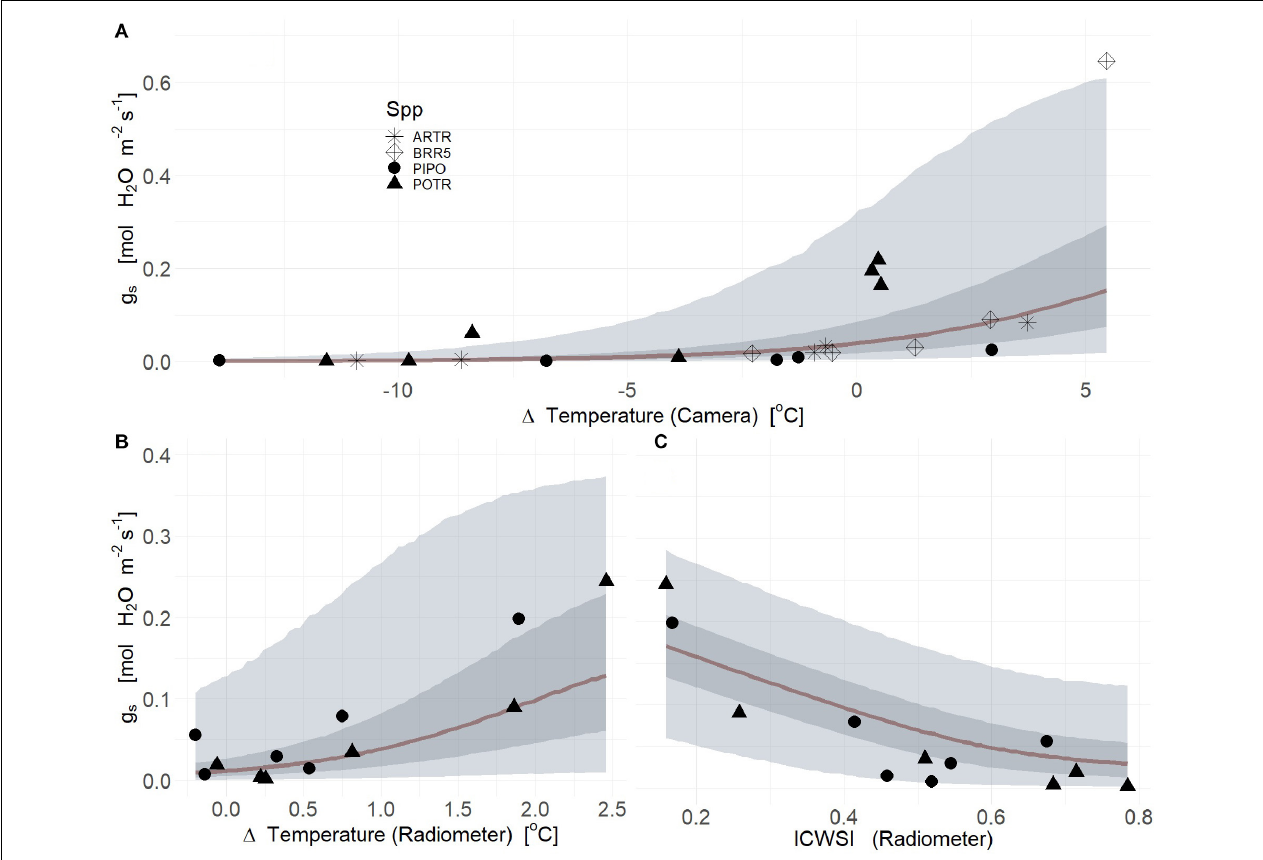
FIGURE 6 | Thermal images (A) Infrared radiometers (B,C) measured deltaT (air minus leaf temperature) (A,B) and I CWSI (C) serve as powerful predictors of the reduction of stomatal conductance ( g s ) in response to soil water limitations for aspen (POTR, triangles), ponderosa pine (PIPO, circles), big sagebrush (ARTR, star), and oilseed Brassica rapa (BRR5, diamond). The maximum likelihood estimates (MLE, red) for the reduction of g s consequent to soil water limitations is presented and the 50% (dark gray) and 94% (light gray) creditable intervals for deltaT and I CWSI